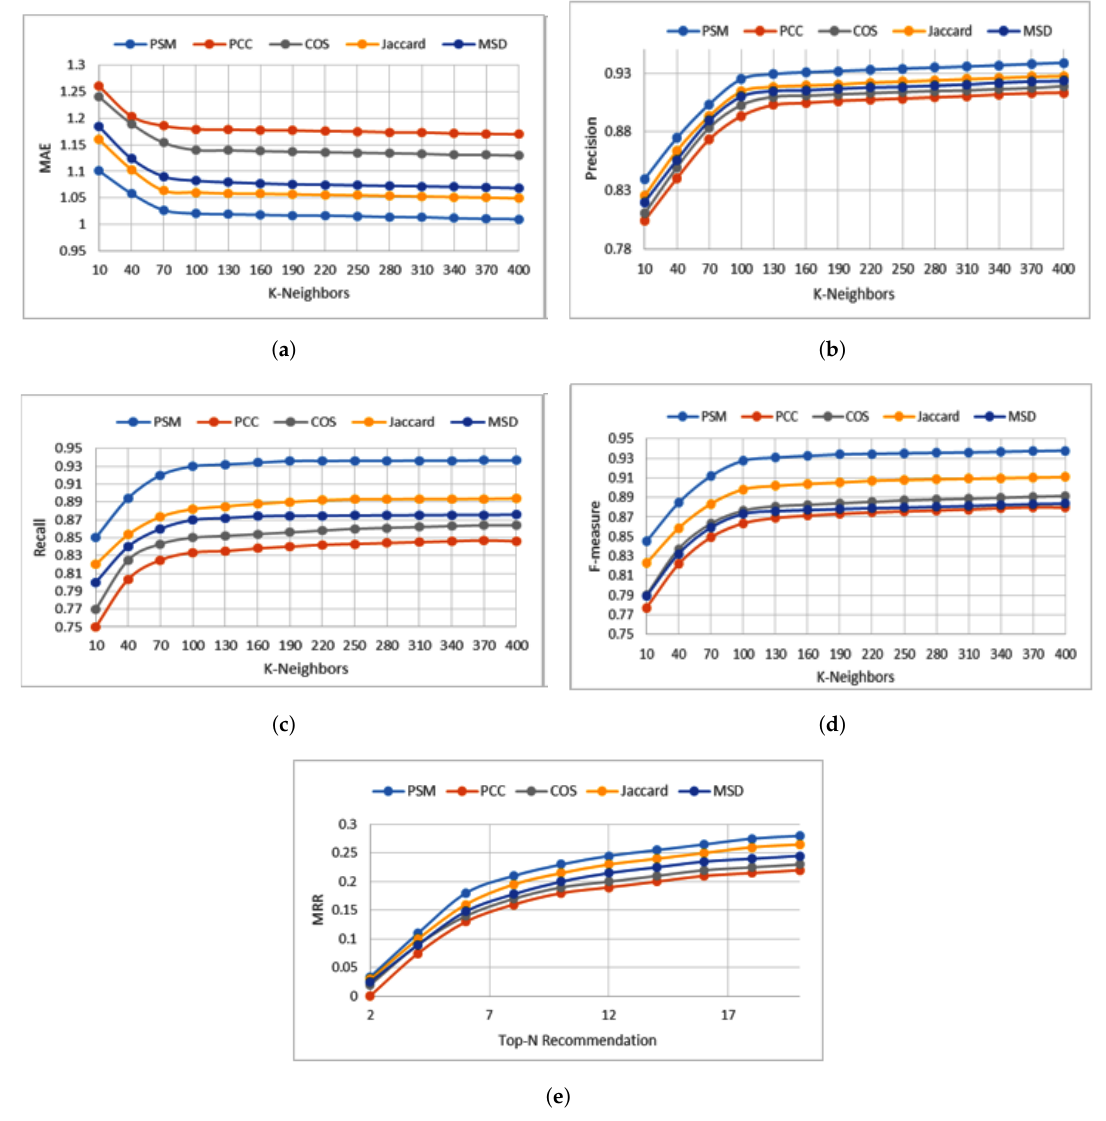
Figure 4. Differentiation of proposed and benchmark methods on basis of ( a ) MAE; ( b ) precision; ( c ) recall; ( d ) f-measure and ( e ) MRR for MovieTweets dataset.